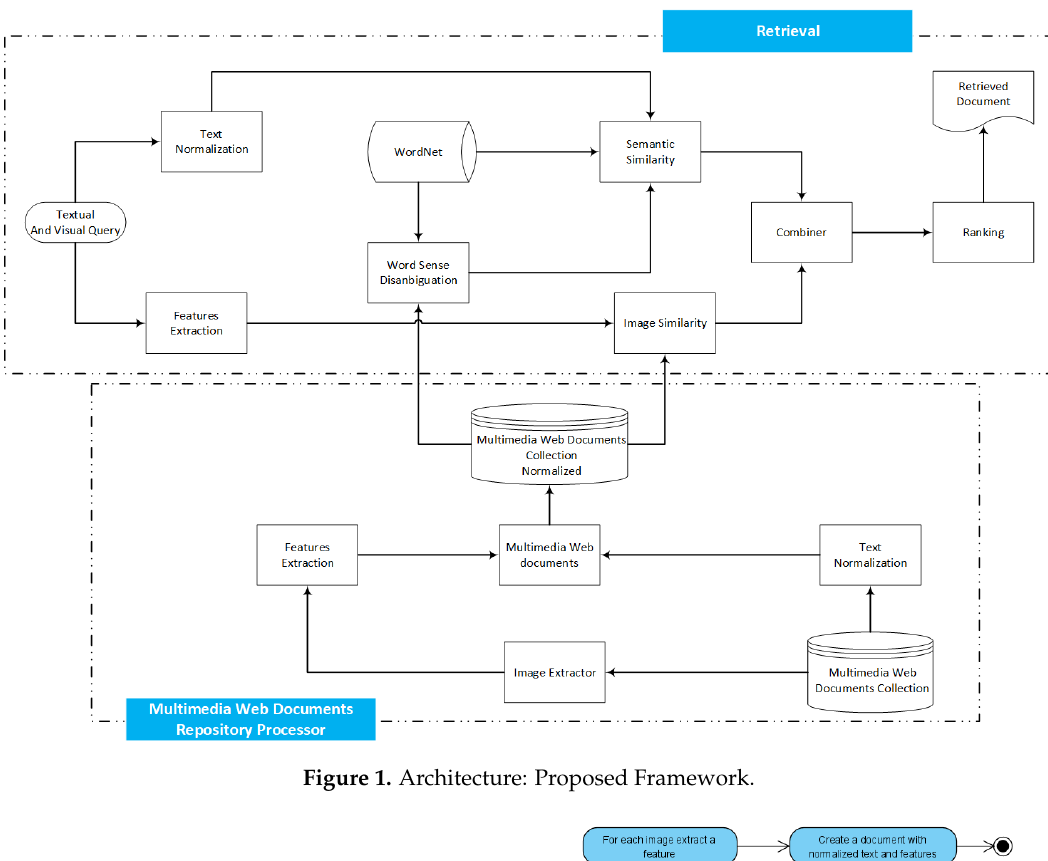
Figure 1. Architecture: Proposed Framework.